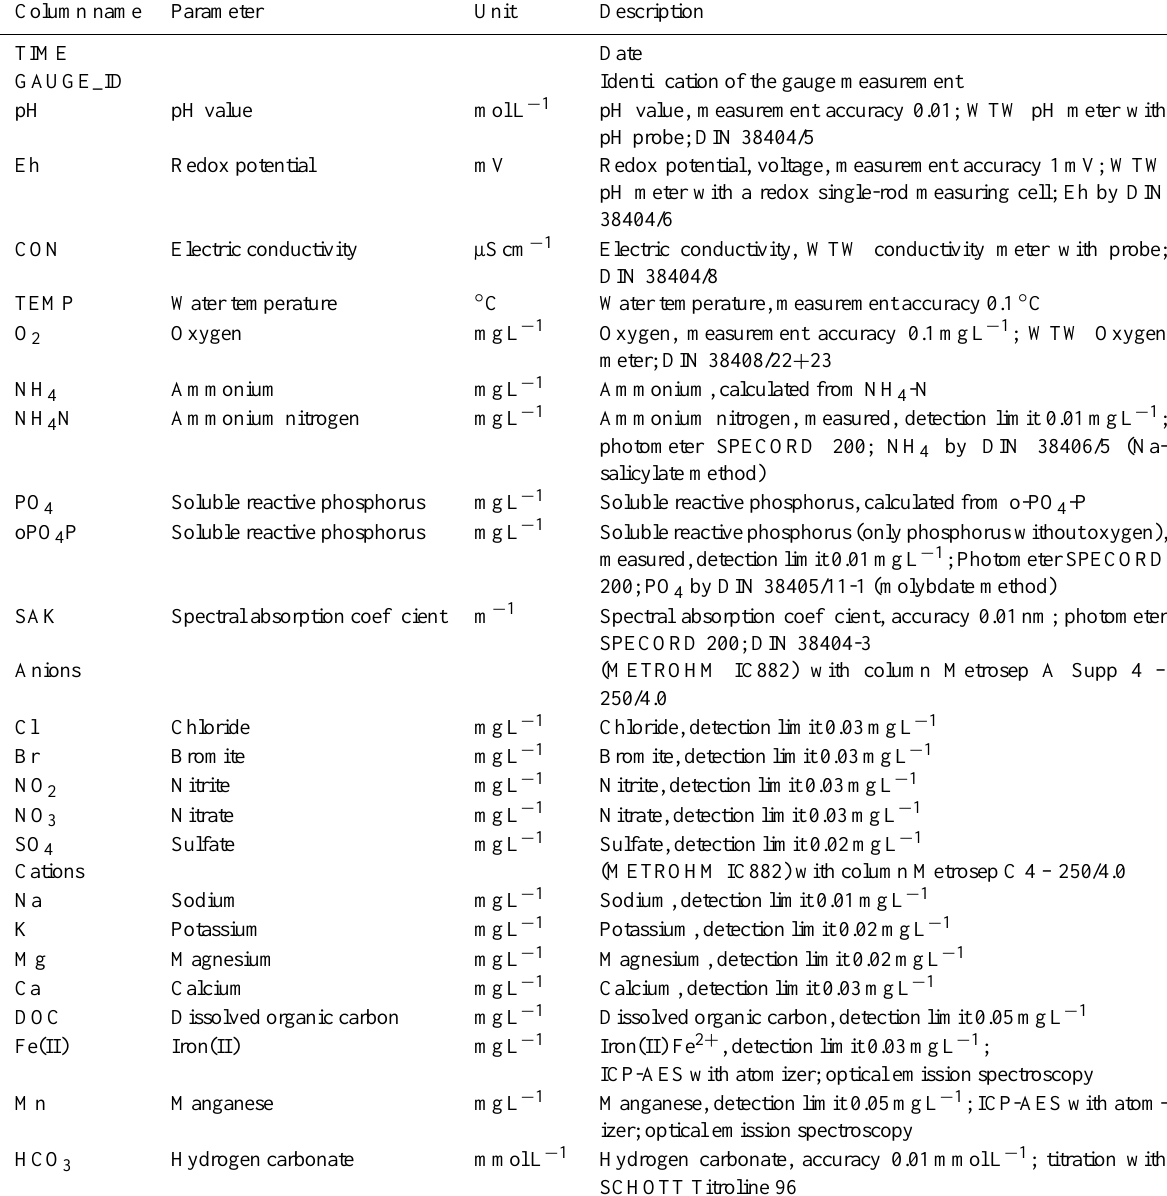
Table 1. Geochemical database content and